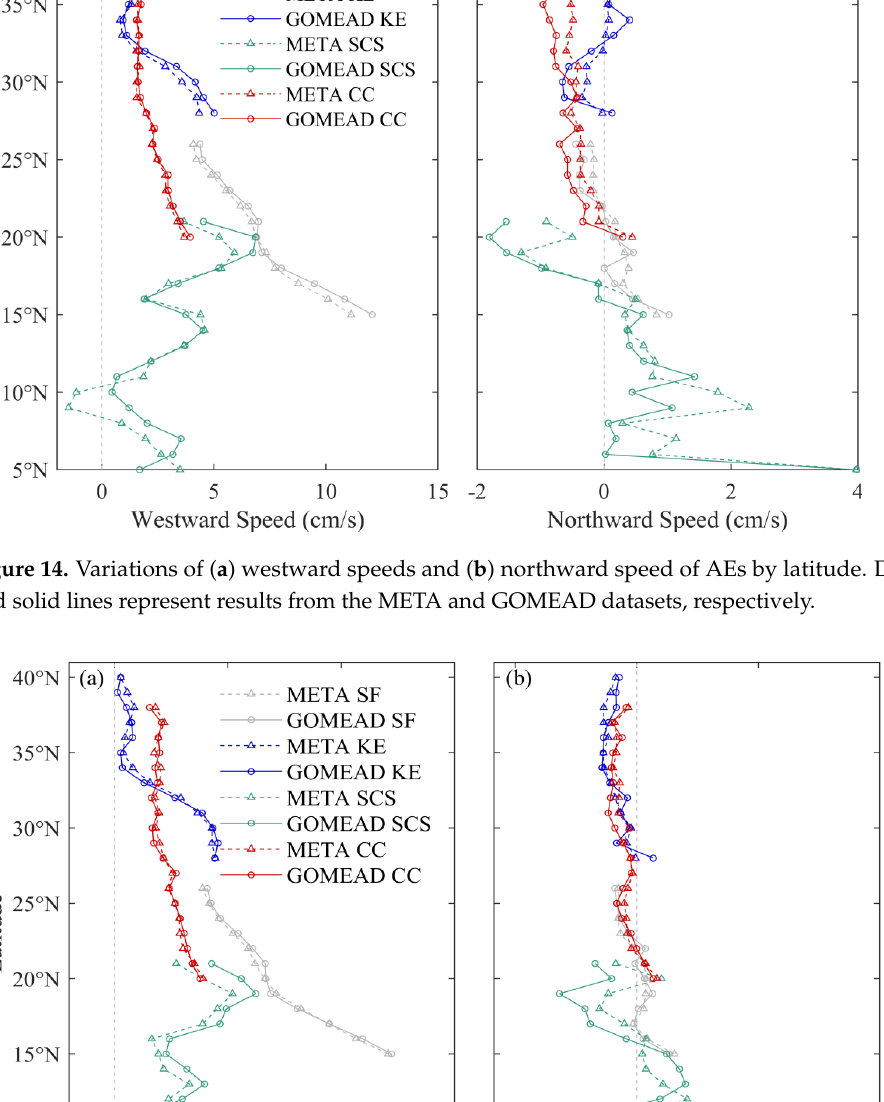
Figure 15. Same as Figure 14, but for CEs. Figure 15. Variations of ( a ) westwards and ( b ) northwards speeds of CEs by latitude. Dashed and solid lines represent results from the META and GOMEAD datasets,